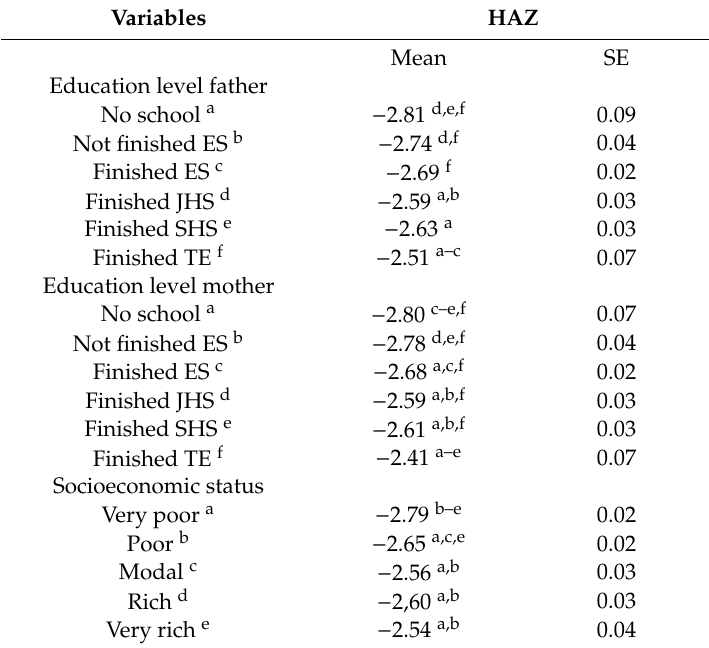
Table 2. Relationship between parental education level, socioeconomic status and height for age Z-score (HAZ) in Indonesian stunted children (HAZ < − 2 SD)